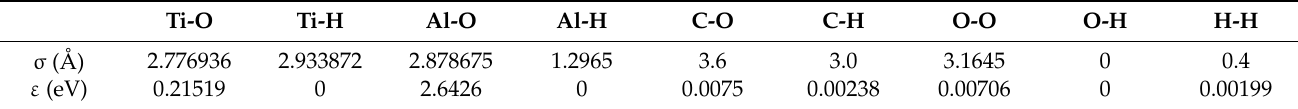
Table 4. Inter-atomic L-J potential